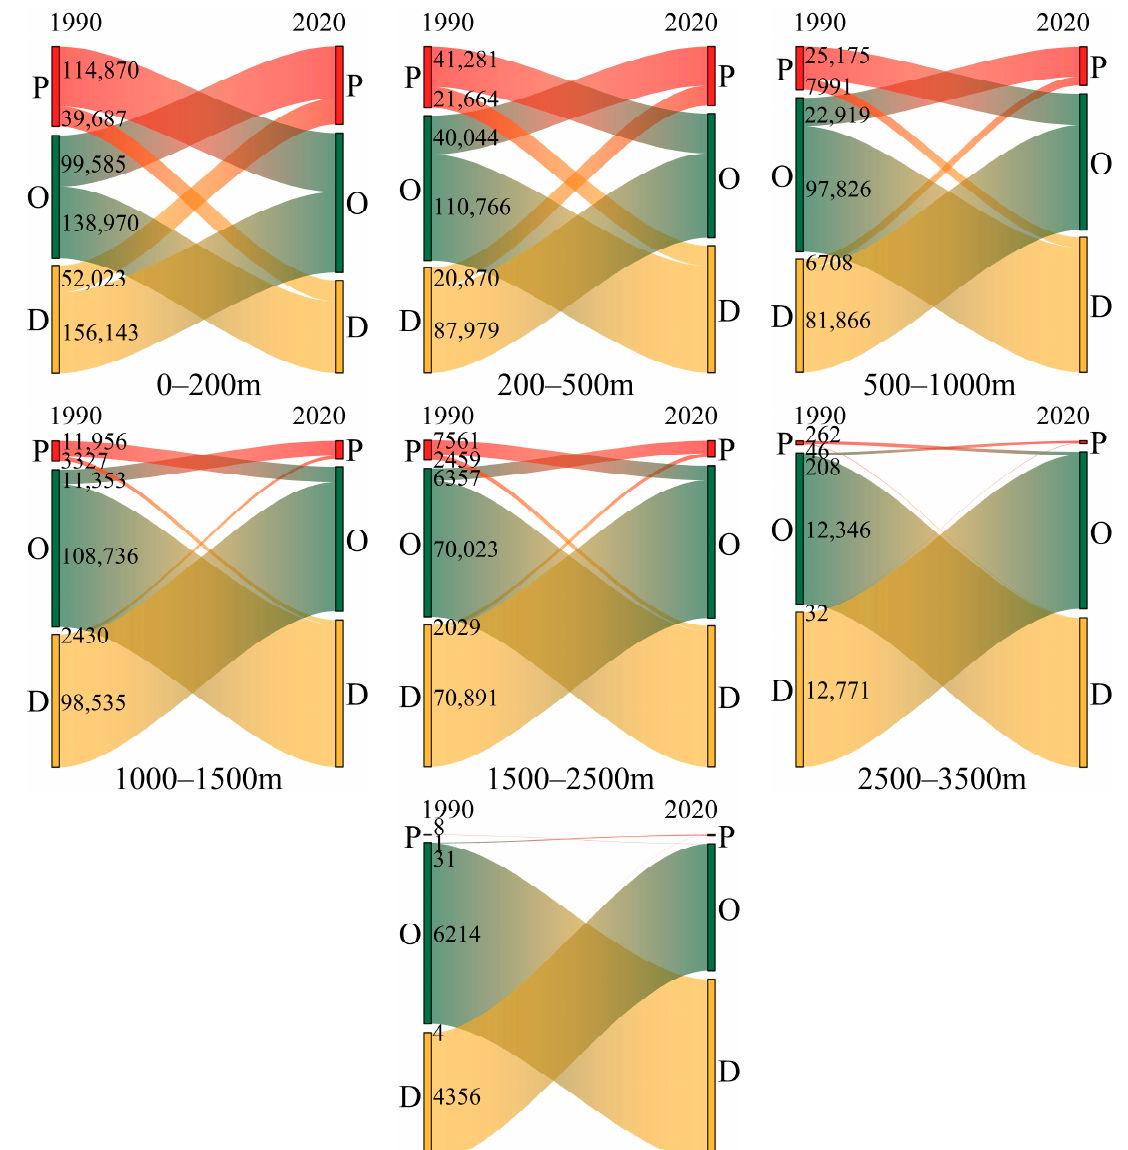
Figure 6. Land conversion between paddy field, dry land, and other land at different elevations from 1990 to 2020. P, paddy field; D, dryland; O, other land. The numbers in the figures refer to the area among the land changes (km 2